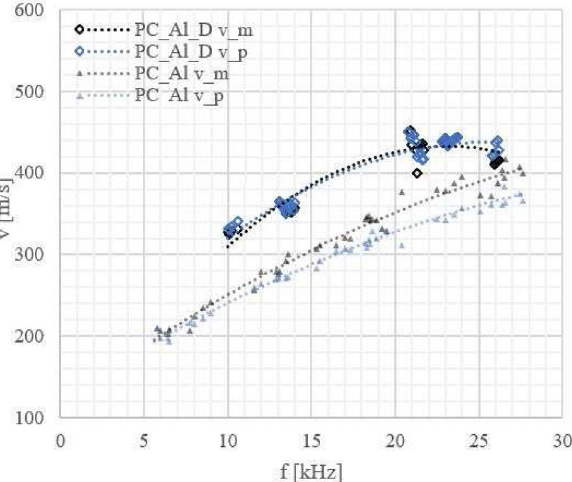
Figure 8. Lamb wave phase velocities for PC_Al laminates without and with a defect:_D_; measurement errors: (cid:31) f = 1 Hz, (cid:31) v = 10 m/s. Velocities of the Lamb waves are marked: in black (v_m) for the metal part, in blue (v_p) for the polymer part, △ for laminates without and ⋄ for laminates with a